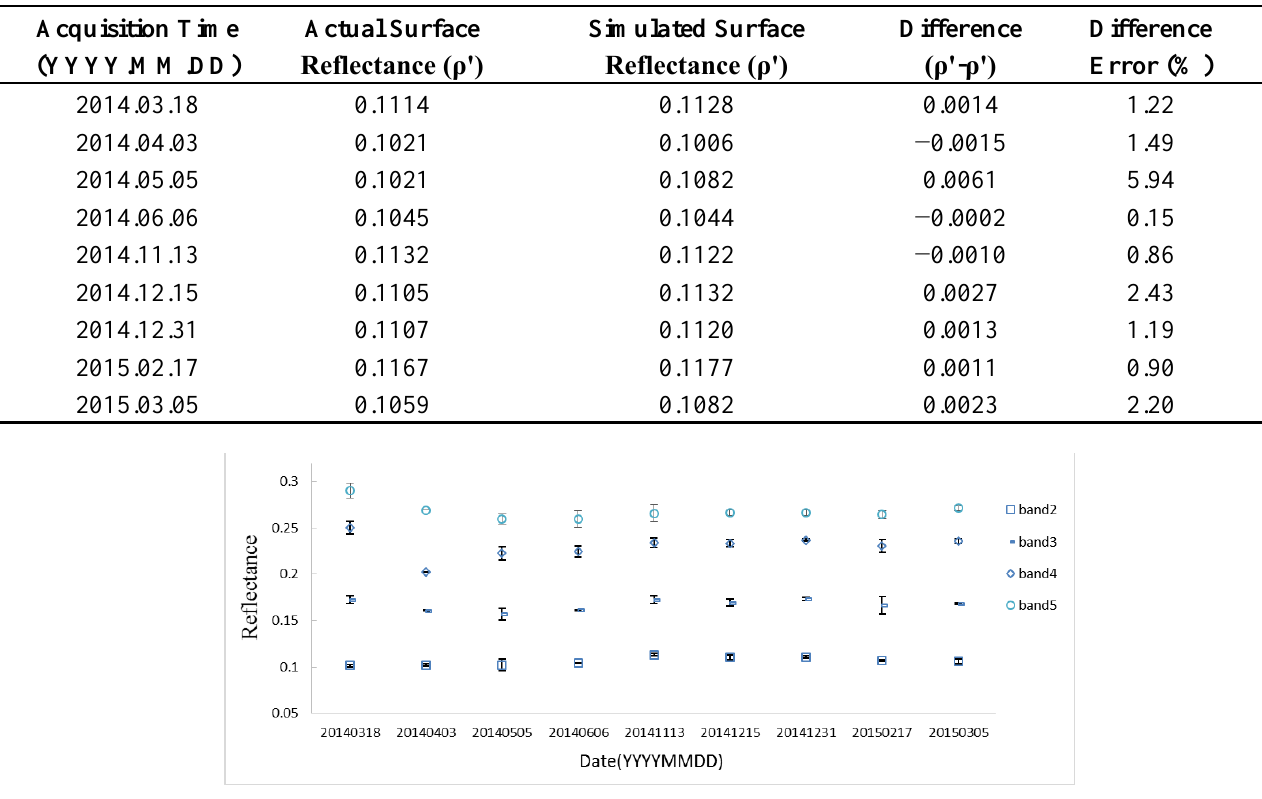
Figure 7. Difference error between the actual and simulated surface reflectance for OLI bands 2–5 corresponding to the lines in the figure from bottom to top,